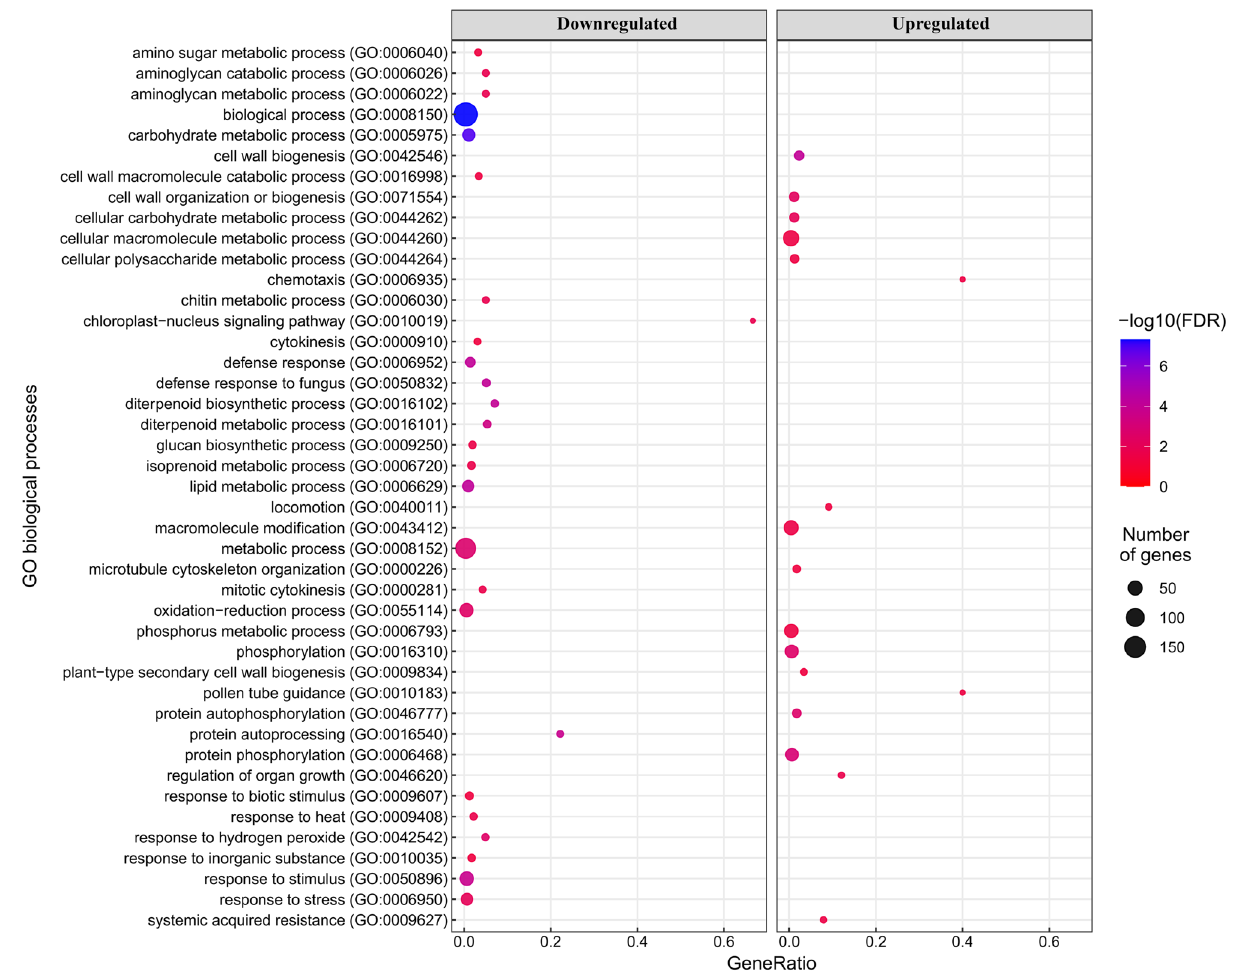
Figure 4. Biological Processes GO terms enrichment analysis for upregulated and downregulated genes. The dot plot shows enriched GO terms (FDR < 0.05) identified with PANTHER using the Fisher’s exact test. The size of the dots represents the number of genes in each GO biological process while the GeneRatio (x-axis) is the ratio between the number of DEGs found and the number of genes in that